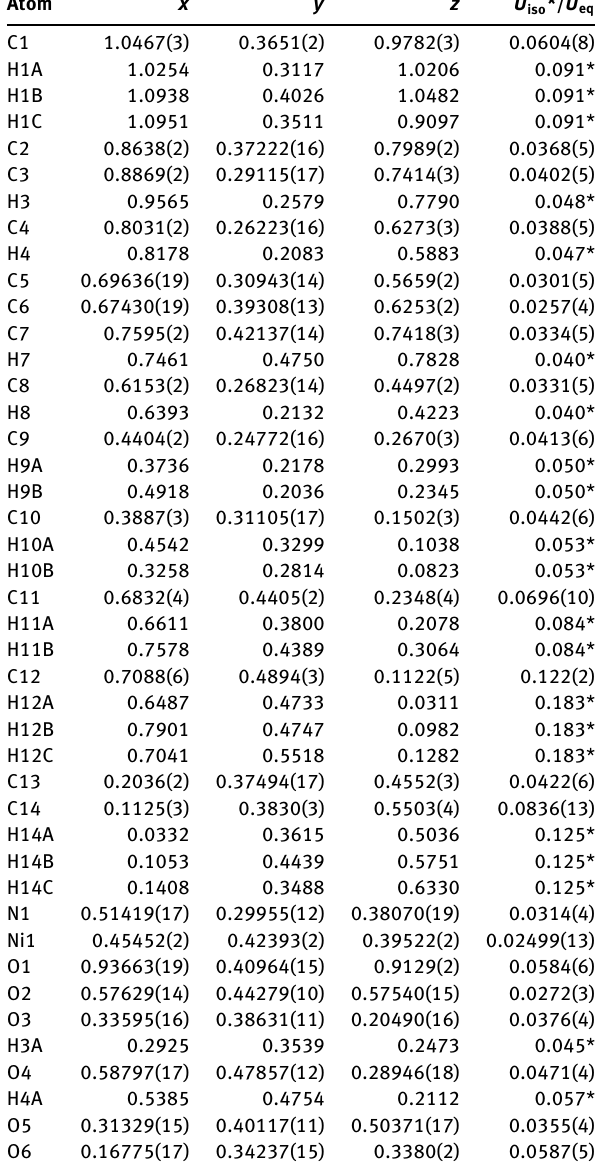
Table 2: Fractional atomic coordinates and isotropic or equivalent isotropic displacement parameters (Å 2 ).